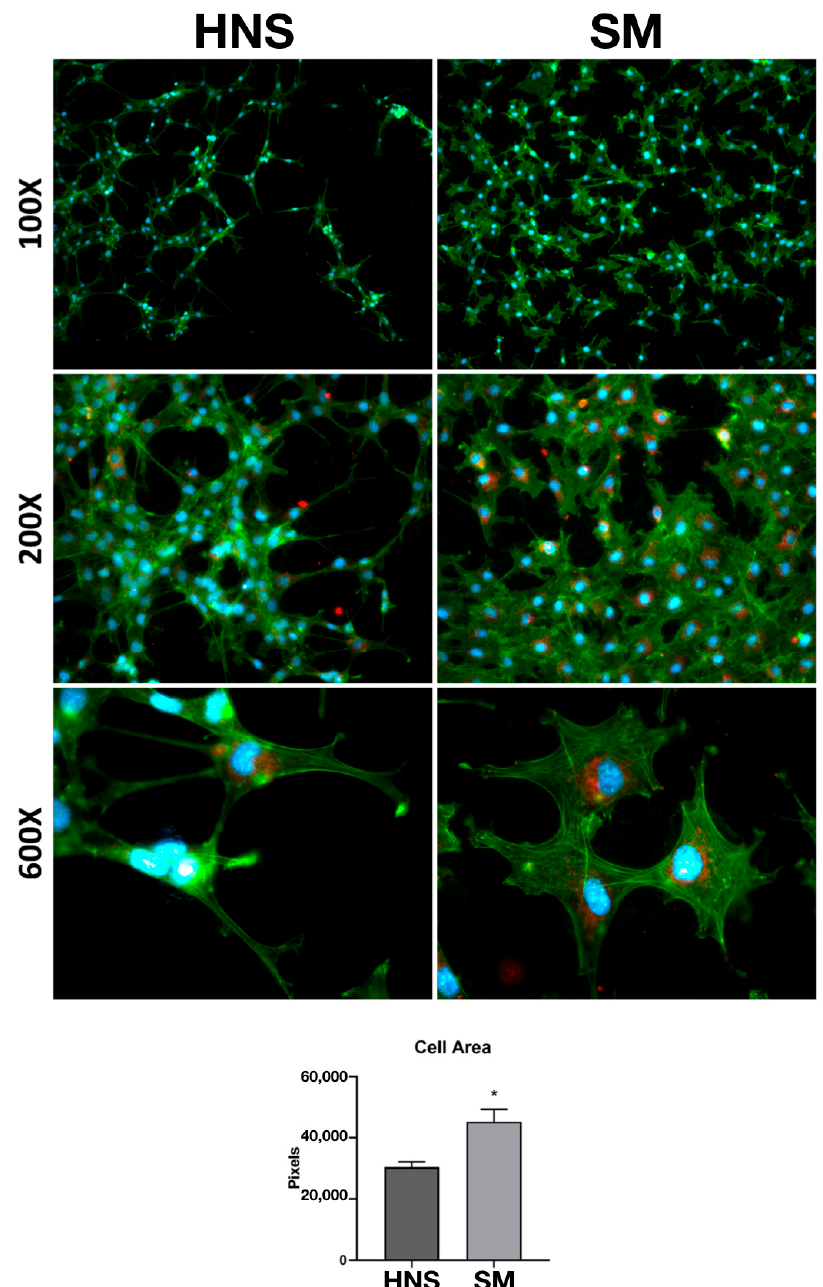
Figure 3. Cell Morphology. MC3T3-E1 seed on HNS and SM sample after 24 h. Staining for Focal Adhesions (Paxillin in red), cytoskeleton (actin, Alexafluor 488-phalloidin in green), neclui (DAPI in blue). Images were acquired at 100, 200, and 600 magnifications. Quantification of cell area performed with ImageJ. Values represent mean ± SEM. The symbol (*) indicates the statistical significance vs. HNS surface, considering a p -value < 0.05.